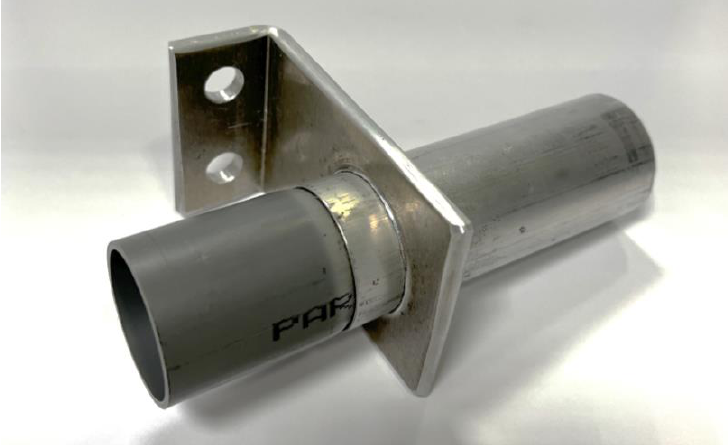
Figure 12. Example of PVC – Al tube connection produced by a sheet flange, having two holes for subsequent assembly. subsequent